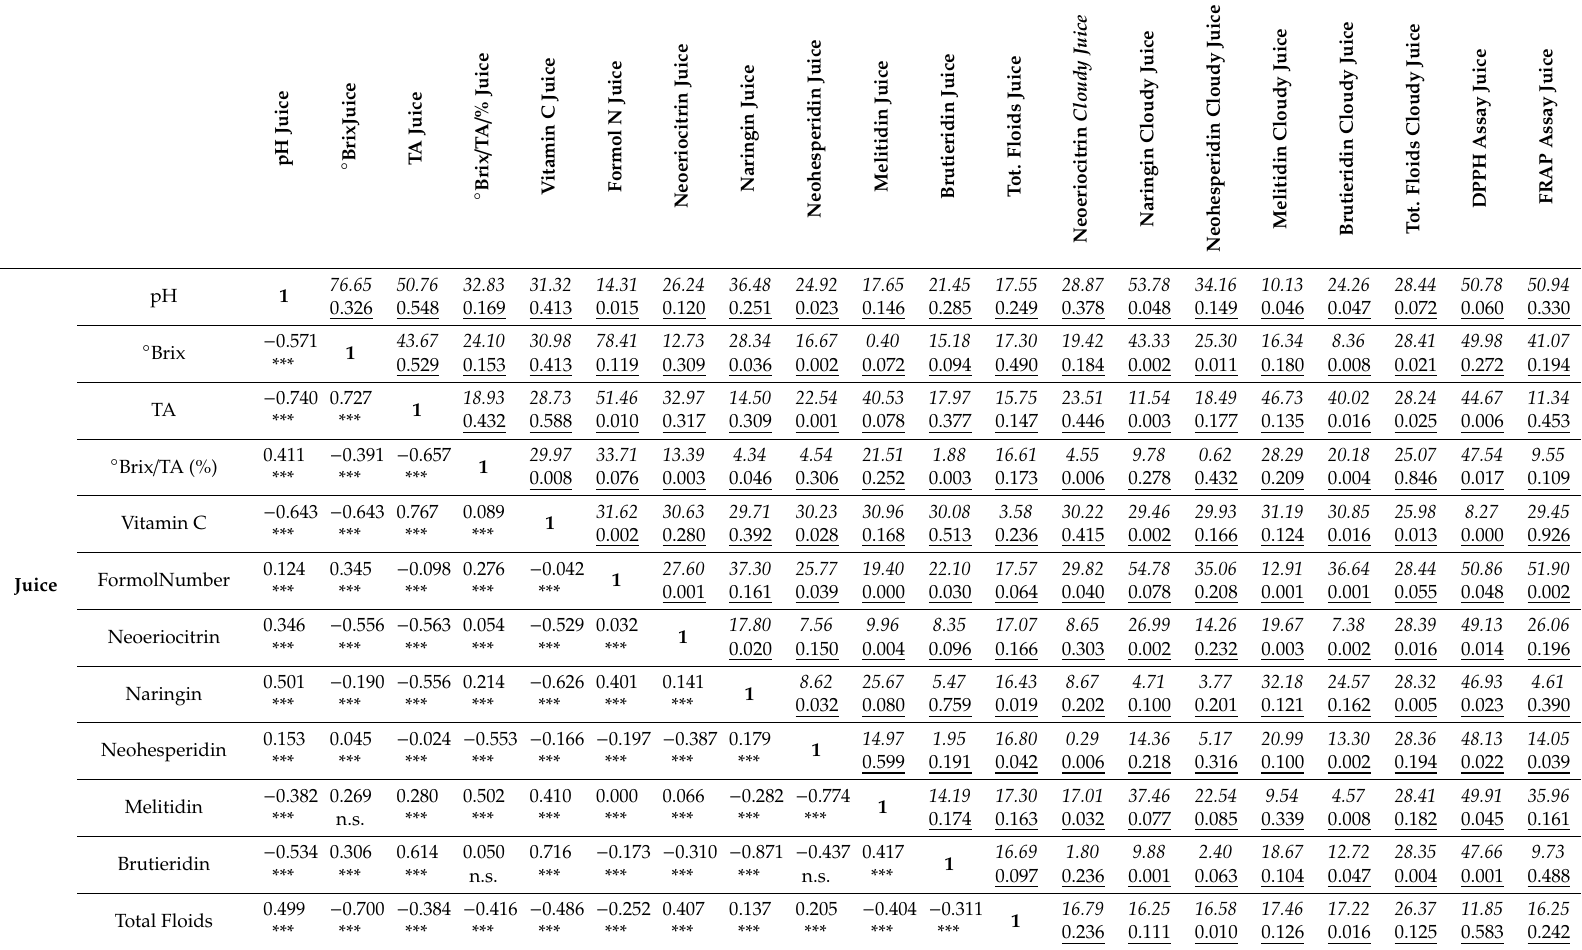
Table 5. The correlation matrix of the physico-chemical properties of bergamot juice and bergamot cloudy juice which is built on the basis of 48 values for each parameter (4 replicates × 2 harvest years × 3 cultivars). In the south-west section of the matrix is the r-value (above) and the significance level (below) with p < 0.05, *. In the north-east section of the matrix there is the t -value (in italics) with the significance of the t -test calculated at 95% confidence interval and the R 2 value